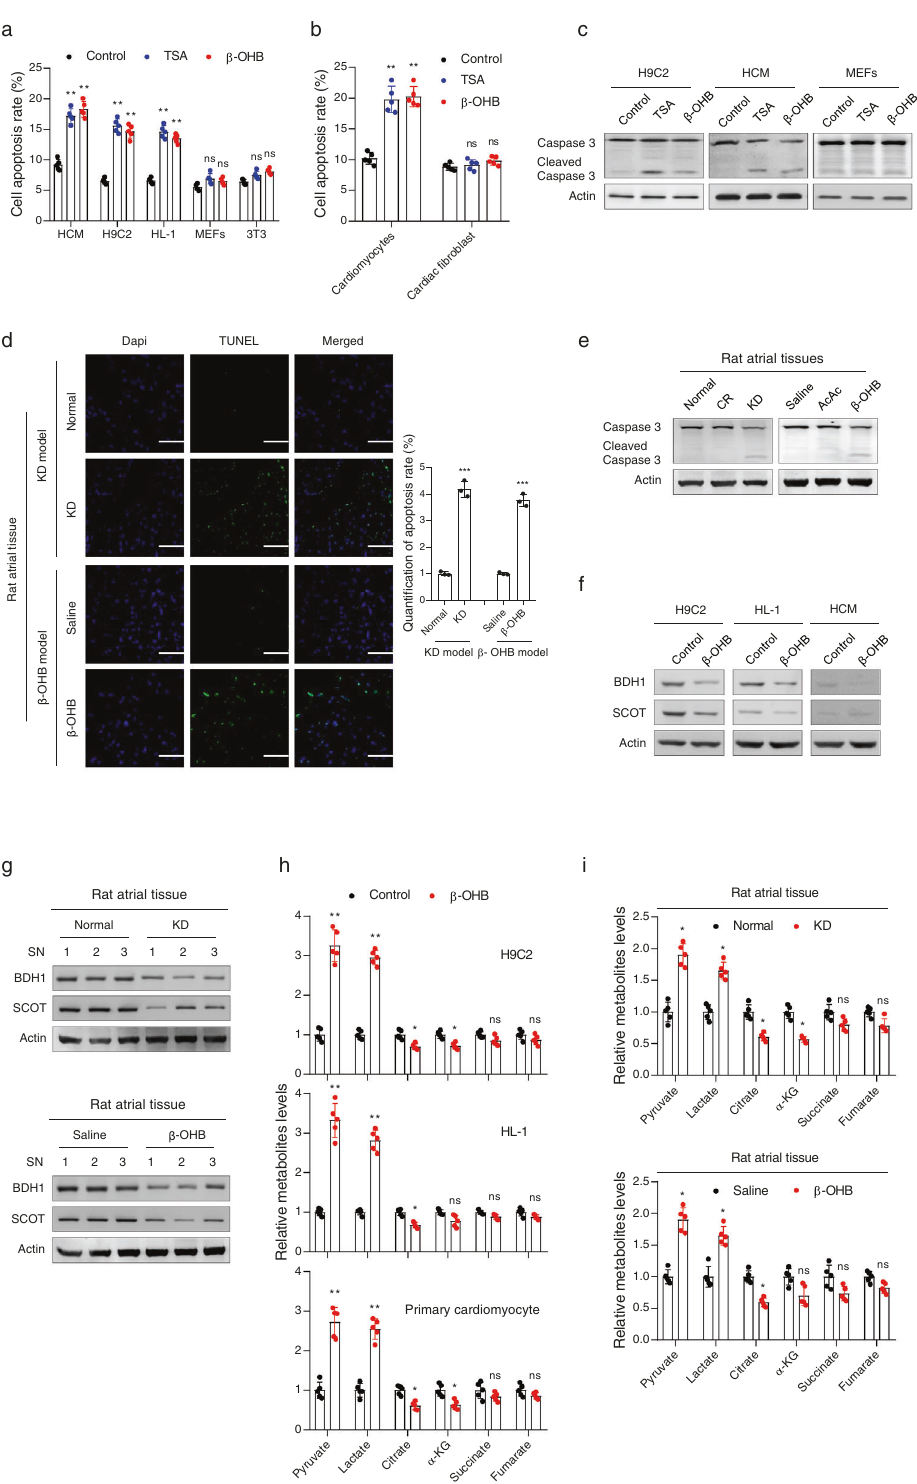
Fig. 2 Increased β -OHB promoted cardiomyocyte apoptosis by decreasing mitochondrial metabolism. a Cell apoptosis associated with various treatments in different cultured cell lines. Trichostatin A (TSA) is a general histone deacetylase inhibitor; n = 5. b Cell apoptosis associated with various treatments in primary cells isolated from neonatal mice; n = 5. c Western blotting analysis of caspase 3 in different cell lines with various treatments. d TUNEL analysis of atrial tissues from rats with different treatments; n = 3. e Western blotting analysis of caspase 3 in atrial tissues from rats with various treatments. f Western blotting analysis of BDH1 and SCOT in different cell lines treated with or without β -OHB. g Western blotting analysis of BDH1 and SCOT in atrial tissues from rats with various treatments. h Metabolite concentrations in cell lines and primary cardiomyocyte treated with or without β -OHB; n = 5. i Metabolite concentrations in atrial tissues from rats; n = 5. Some full-length blots are presented in the Supplementary Fig. 13